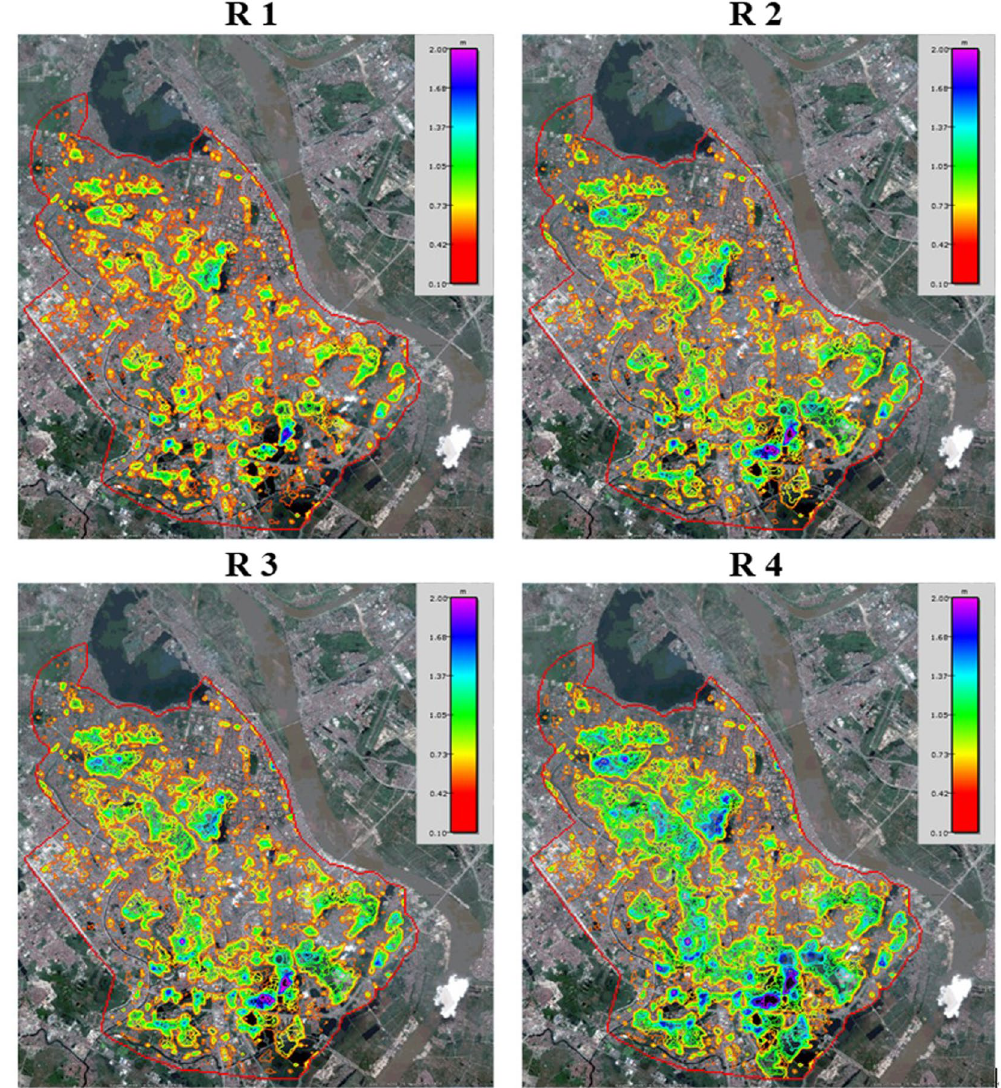
Figure 5. Maximum inundation depth and area under the four rainfall types of ( R1 – R4 ) (Source: Background image map is obtained from the open source of Google Earth which data is from SIO, NOAA, U.S. Navy, NGA, GEBCO and image copyright belongs to 2012